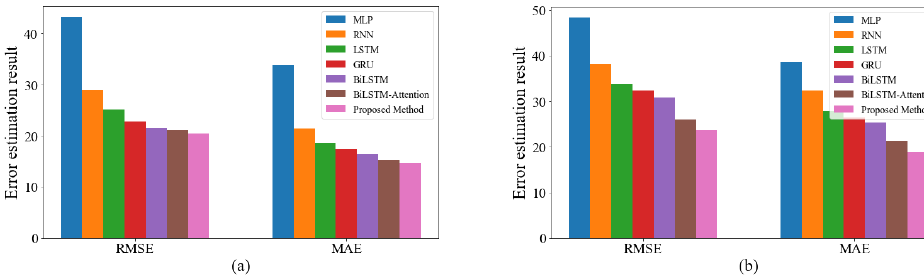
Figure 8. Error estimation result of AEC prediction methods in ( a ) dataset A and ( b ) dataset